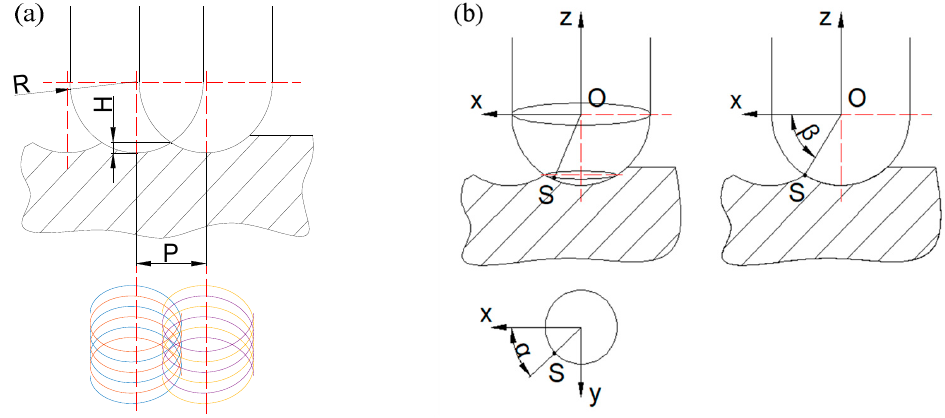
Figure 2. The model of the resulting microgroove: ( a ) the locus of a ball-end milling cutter with two straight flutes. ( b ) coordinate of the locus of the ball-end milling.